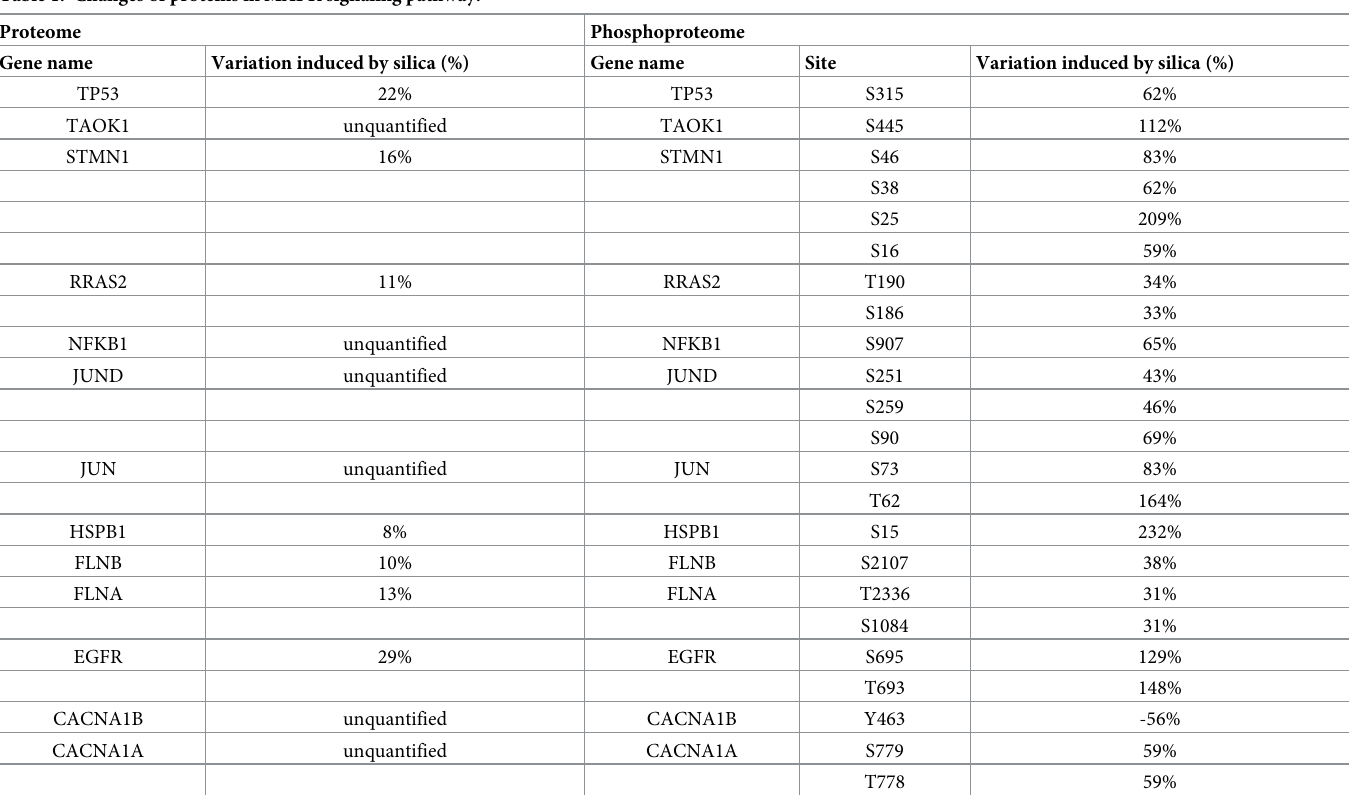
Table 1. Changes of proteins in MAPK signaling pathway. Proteome